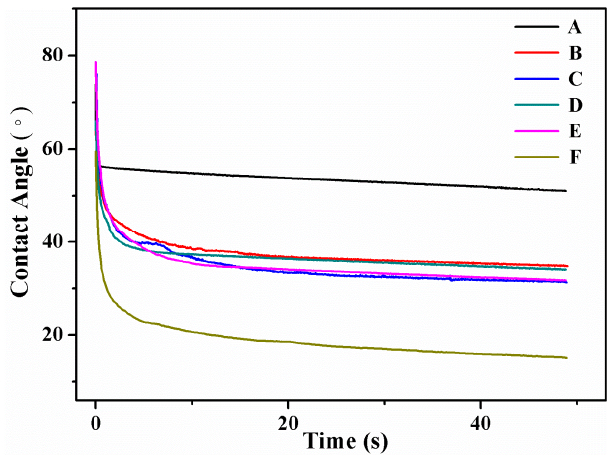
Figure 8. Water contact angle of different SPI-based films.